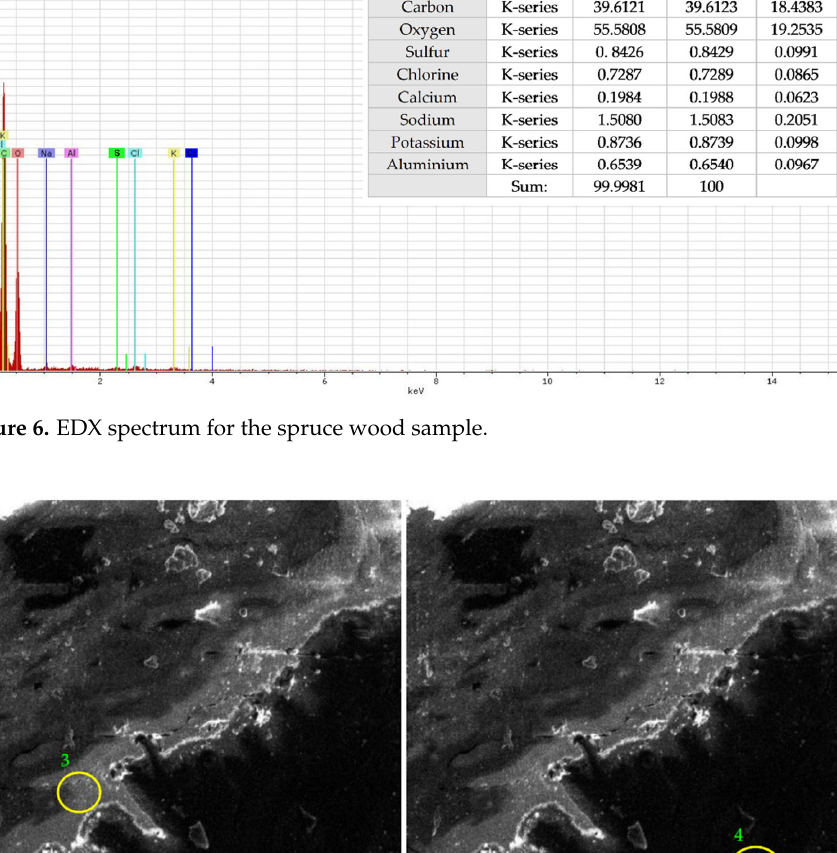
Figure 7. SEM micrograph of the varnish sample (yellow circles represent the analyzed areas).